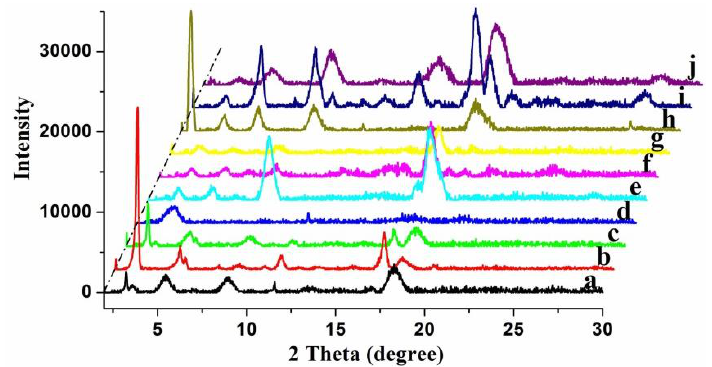
Figure 3. XRD patterns of xerogels from CH-PY gels: ( a – j ) n-butanol, n-pentanol, isopentanol, isooctanol, cyclopentanone, cyclohexanone, nitrobenzene, n-butyl acrylate, THF, DMF,